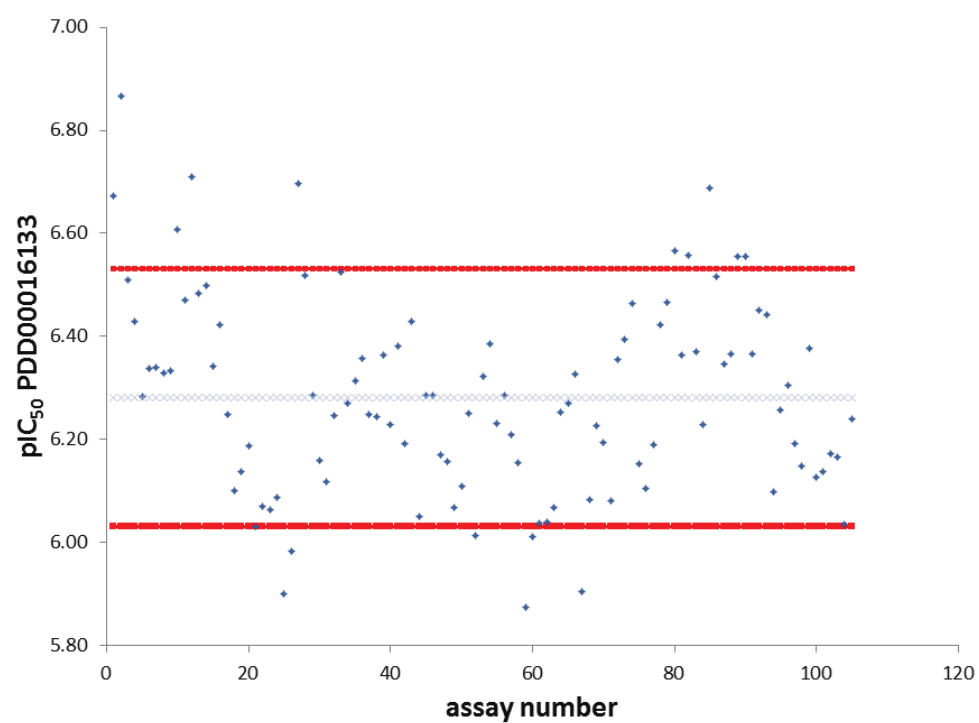
Figure 6. PAR chain assay robustness over time. The PAR assay was run over a period of 2½ years resulting in over 100 assays. The pIC for compound PDD00016133 was plotted for each assay. The pIC 50 is indicated with the red lines.